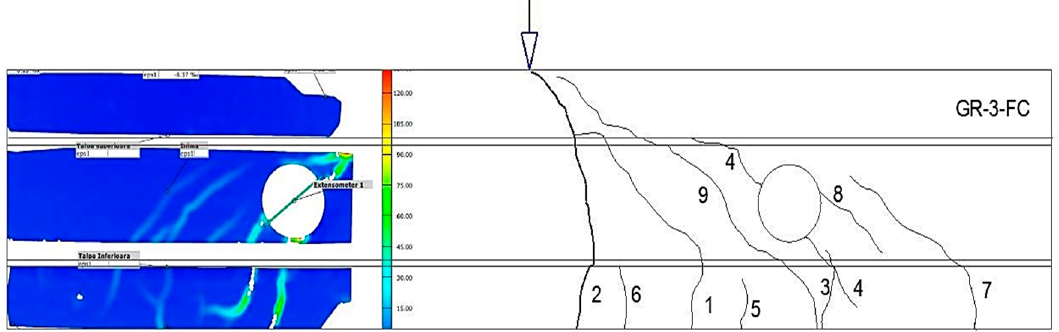
Figure 13. Cracking pattern at ultimate load for the limestone beam (GR-3-FC).